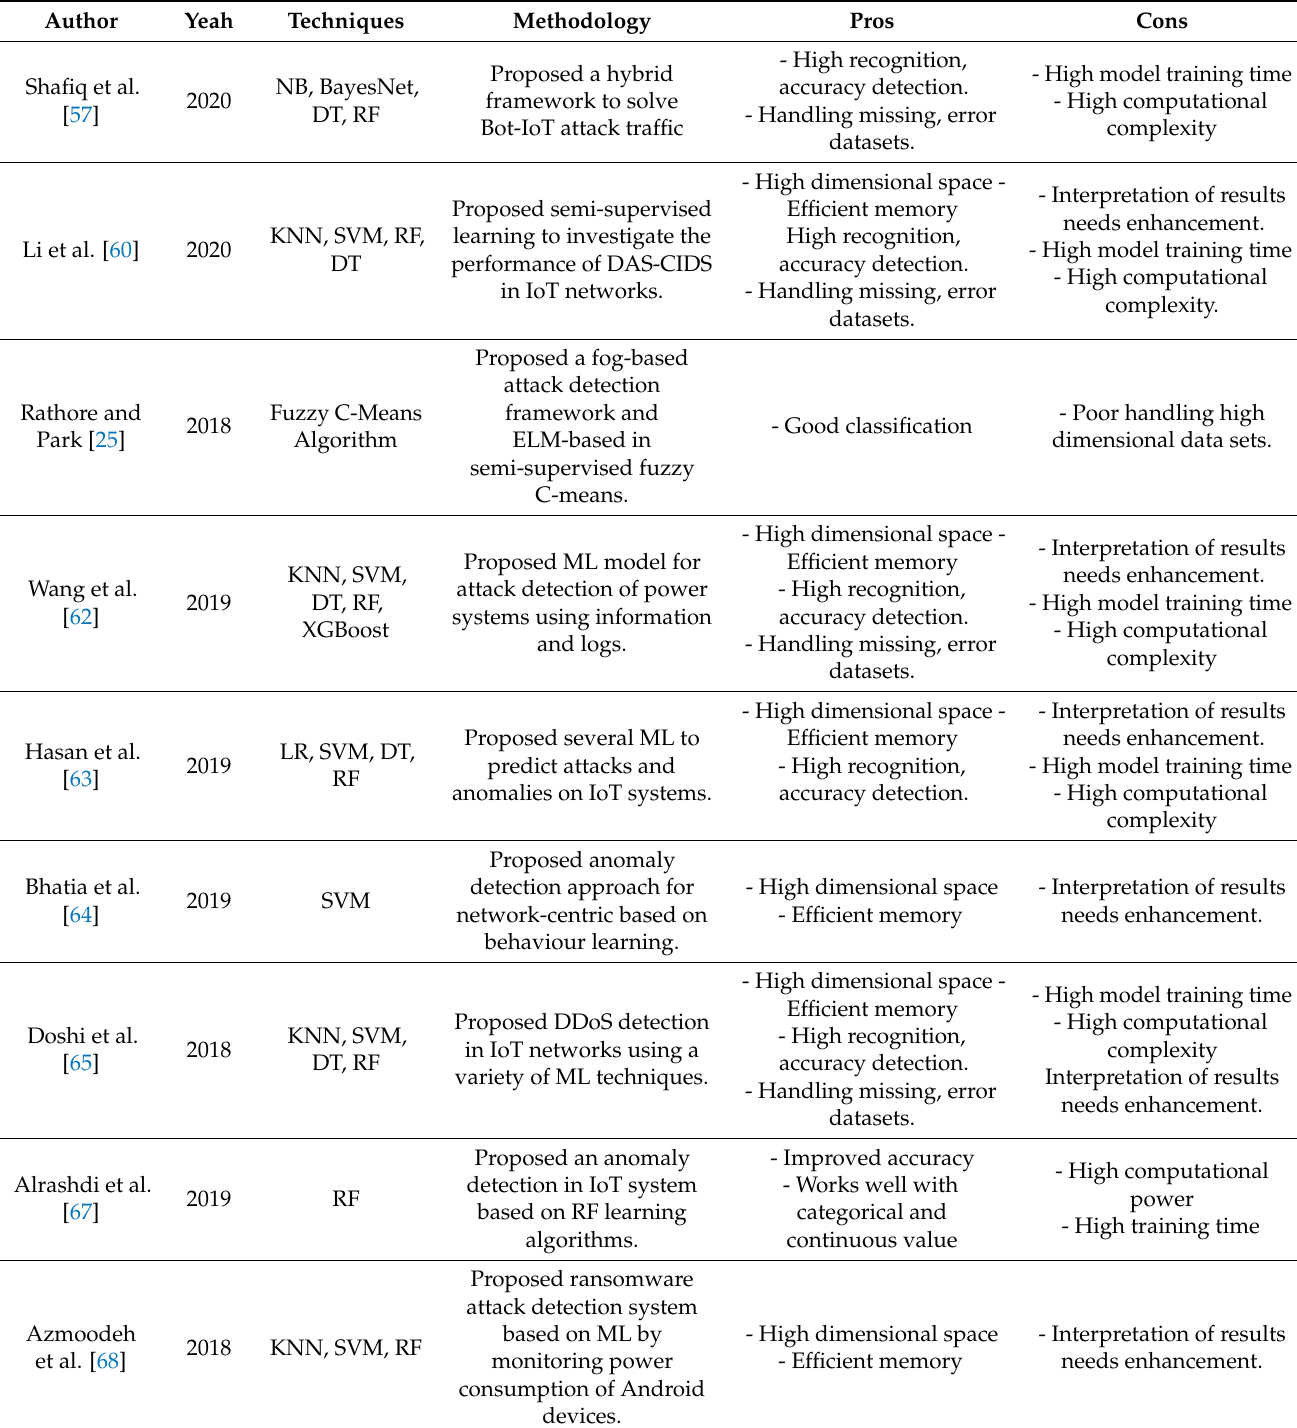
Table 10. List of state-of-art studies with pros and